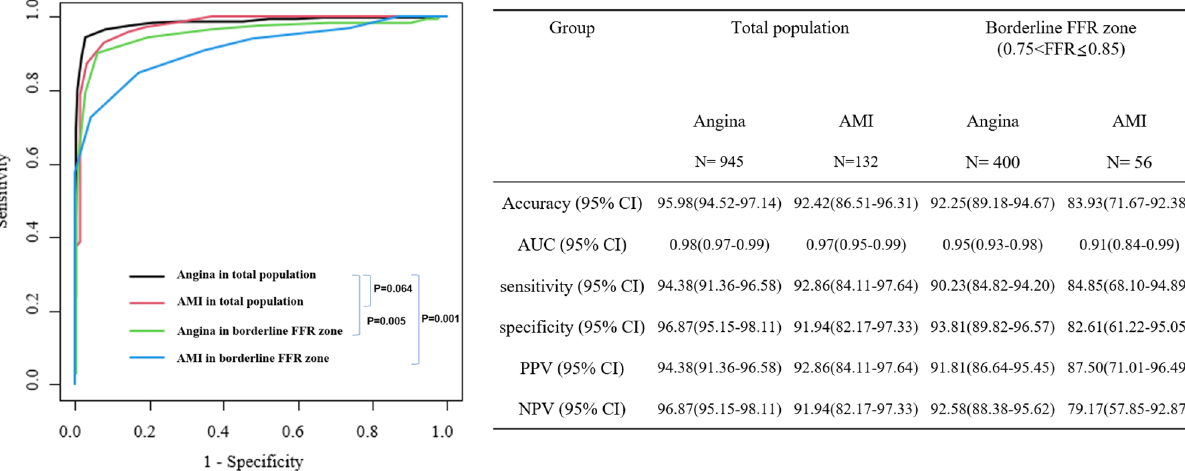
Figure 3. Comparison of the diagnostic performance of QFR for identifying FFR 0.8 in the total population and a subgroup of borderline FFR zone. P values are from the chi-square test or Fisher’s exact test for comparing diagnostic accuracy. AUC the area under the curve, CI confidence interval; other abbreviations in Table 1.